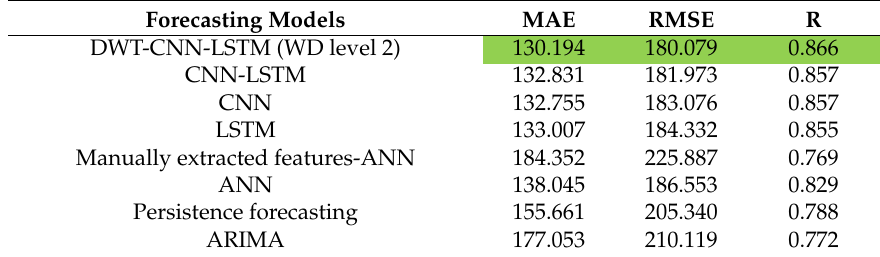
Table 13. The performance comparison of different rainy days’ forecasting models using the dataset of Desert Rock